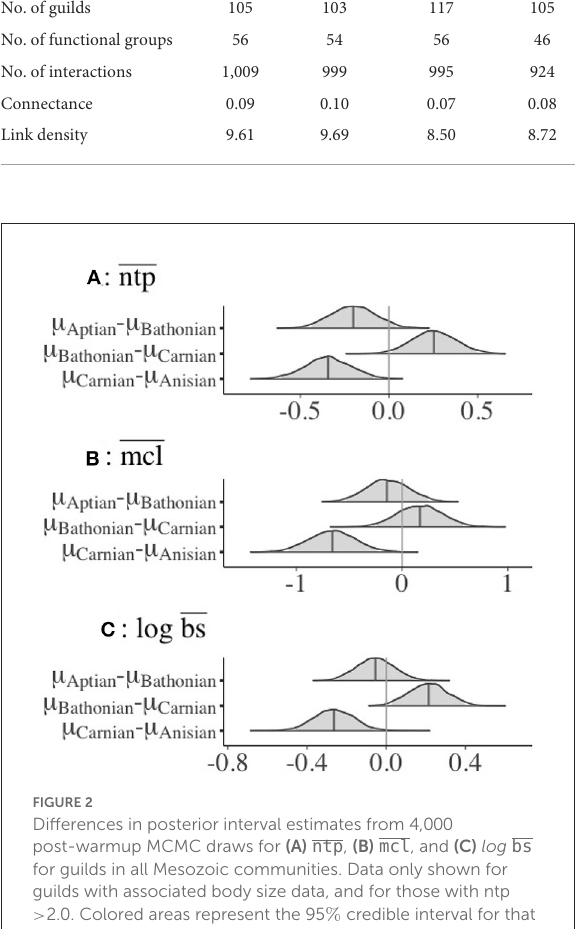
FIGURE2 Differences in posterior interval estimates from 4,000 post-warmup MCMC draws for (A) ntp , (B) mcl , and (C) log bs for guilds in all Mesozoic communities. Data only shown for guilds with associated body size data, and for those with ntp > 2.0. Colored areas represent the 95 % credible interval for that parameter (Supplementary Table